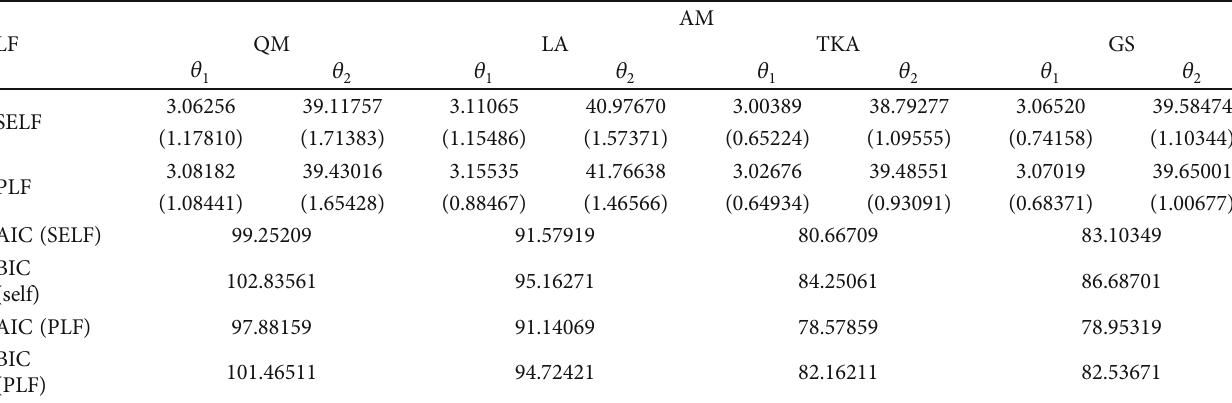
Table 11: BEs and PRs (in parentheses) using real